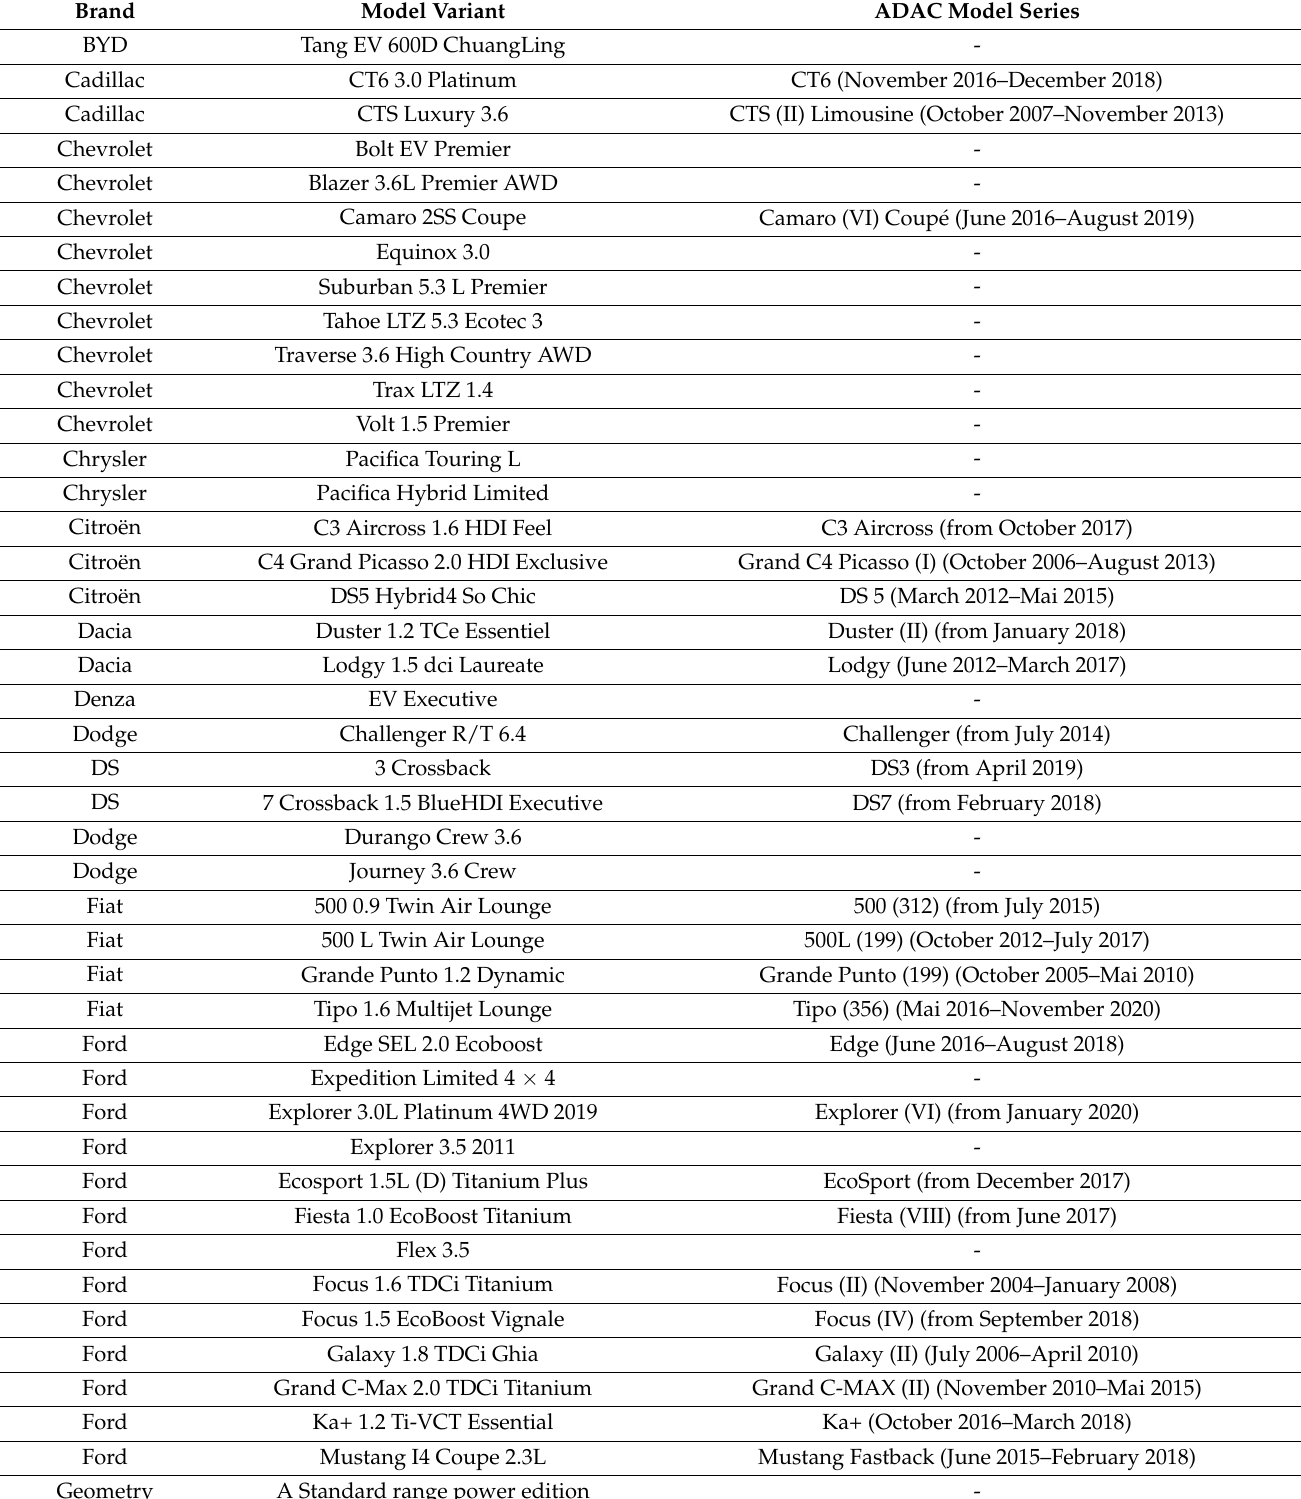
Table A11. Overview of the employed vehicles for the parametric mass model (Part